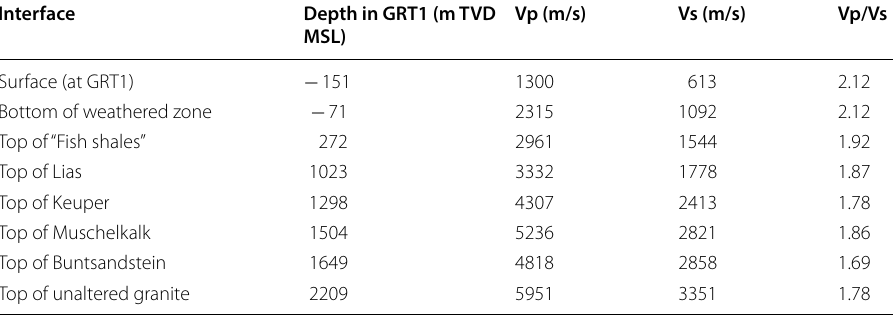
The velocity parameters apply below the depth of the mentioned interfaces, which is given along GRT1